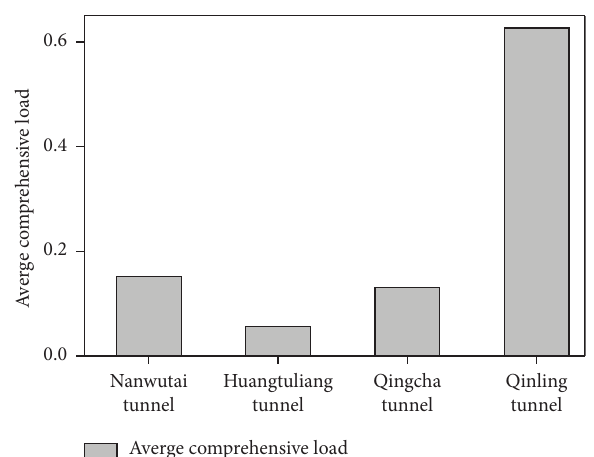
Figure 14: Changes in drivers’ average comprehensive load in each